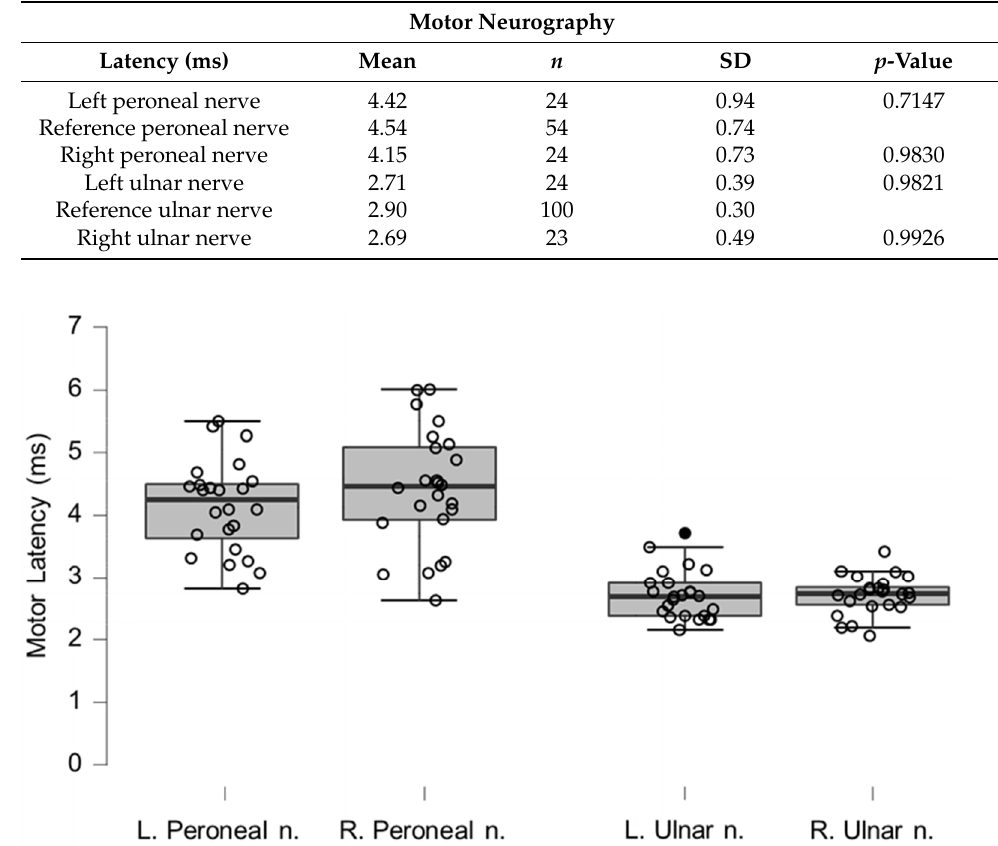
Figure 6. Box-plots for motor neurography latencies. For box plots summary and explanation of symbols, see Figure 2. Table 5. Motor neurography F-wave latencies for left and right peroneal and ulnar nerves.